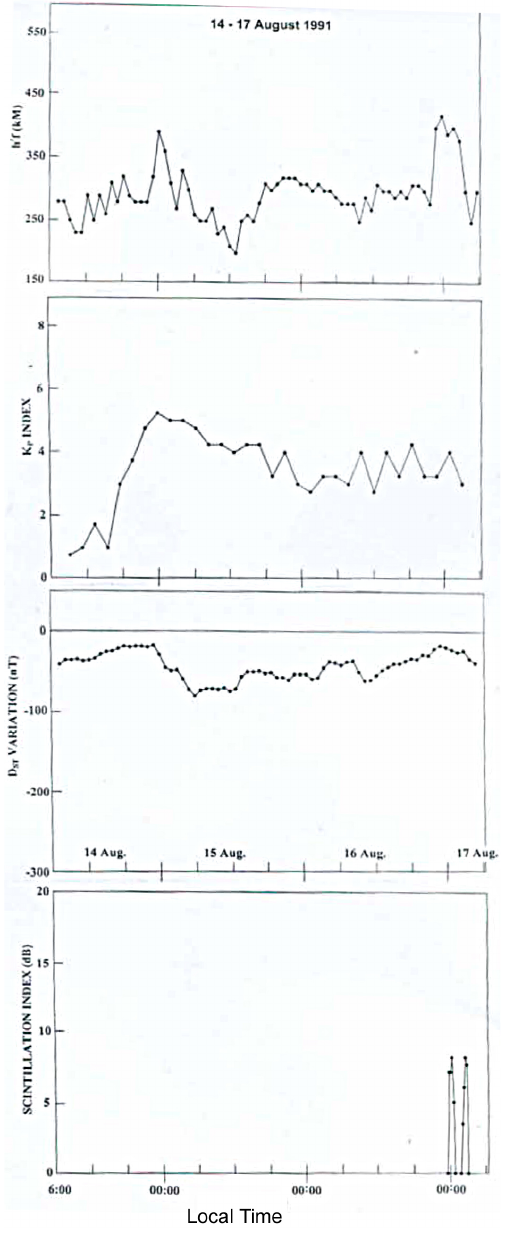
Fig. 7. Example of a magnetic storm that occurred during 14 − 17 August 1991. The top panel is ionospheric F-layer height (h 0 F) at Ahmedabad, the two middle panels are K p and D st and the bot- tom panel shows the occurrence times of scintillation activity at Varanasi.